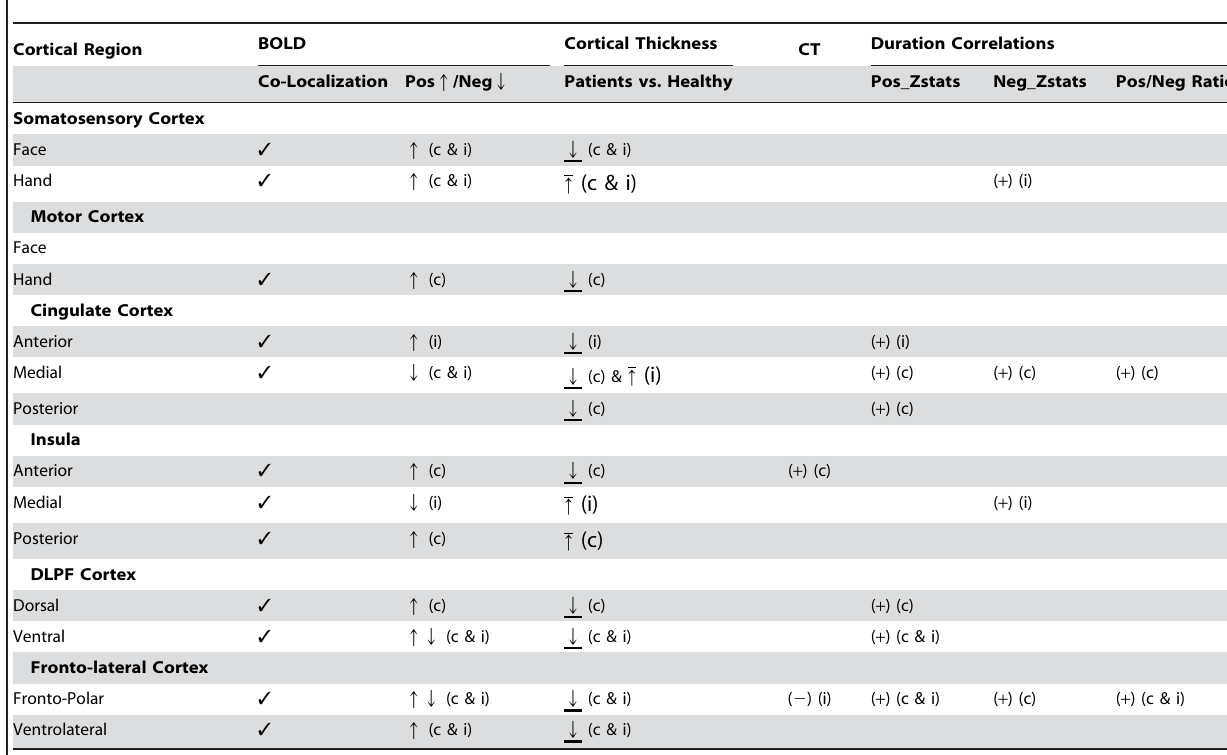
Table 2. Patterns and Correlations of Functional and Anatomical Neuroplasticty in Chronic Trigeminal Pain Patients.